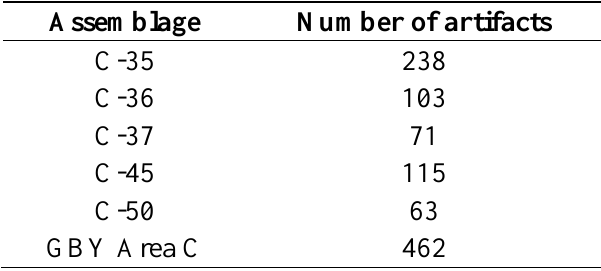
Table 1. Sizes of the